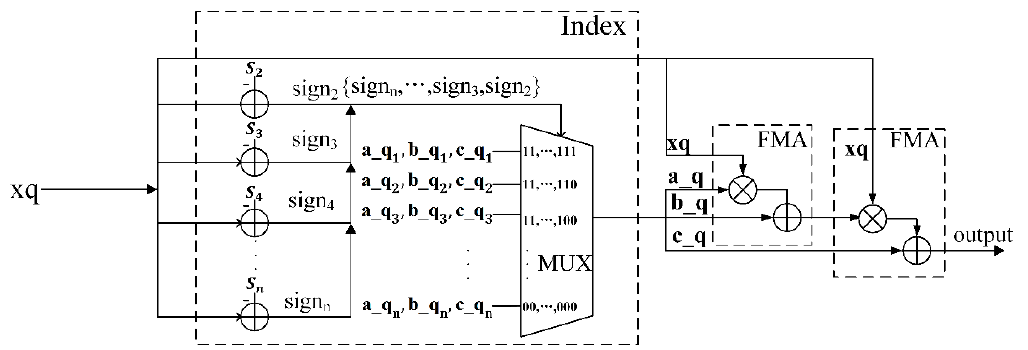
Figure 7. Hardware architecture.